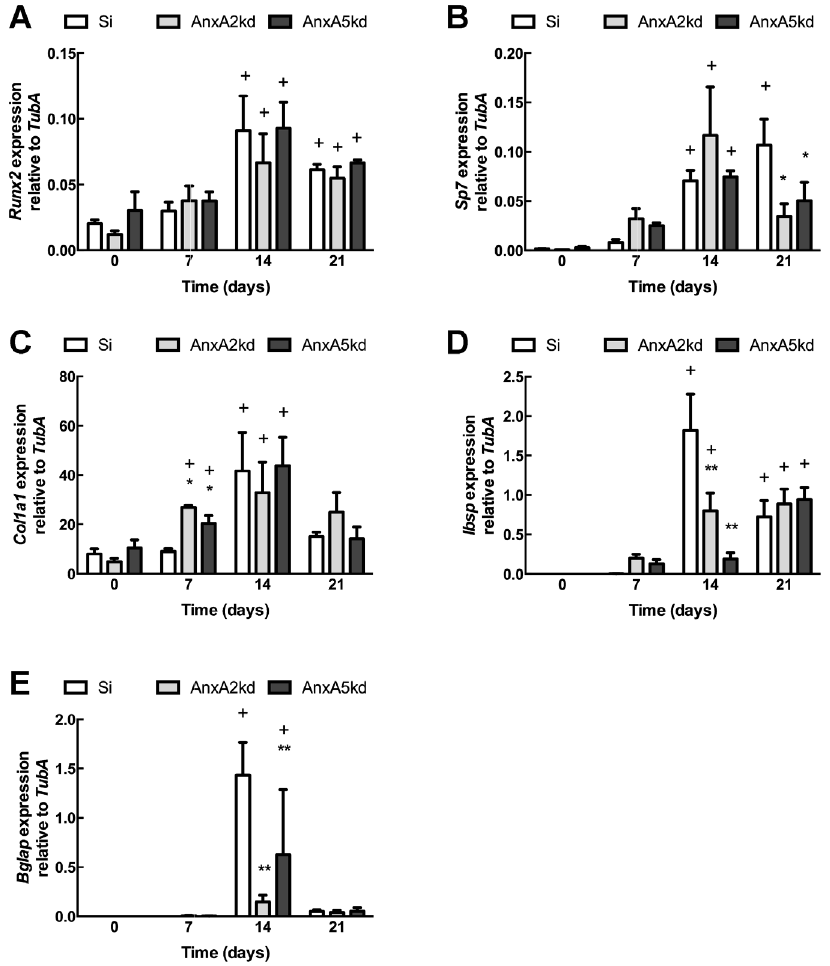
Figure 3. Effects of AnxA2 and AnxA5 knockdown on expression of genes associated with osteogenic differentiation. qPCR analysis of (A) Runx2 , (B) Sp7 , (C) Col1a1 , (D) Ibsp, and (E) Bglap expression in undifferentiated Si, AnxA2 kd and Anx5 kd cells (day 0) and in cells cultured in differentiation medium for 7, 14 and 21 days. Each bar represents mean transcript normalized to a -tubulin 6 SEM, n=3. *, **, ***represent statistically significant difference from Si at same time point, *p , 0.05, **p , 0.01, ***p , 0.001; + represents statistically significant difference from same genotype on day 0, p , 0.05.